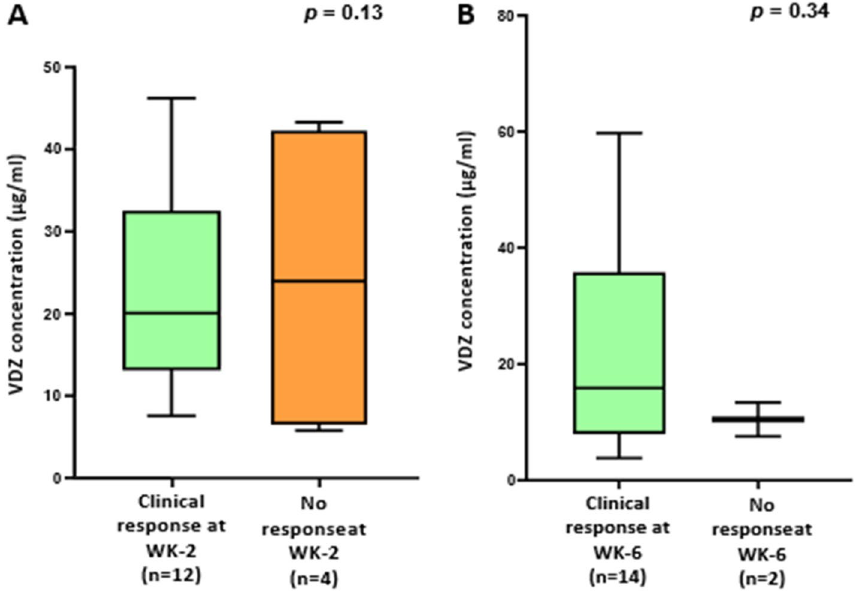
Figure 2. ( A ) A boxplot of Week 2 Vedolizumab trough levels in responders and non-responders. ( B ) A boxplot of trough levels of Vedolizumab in responders to Vedolizumab therapy compared to patients with no response at week 6. P value Mann–Whitney test.